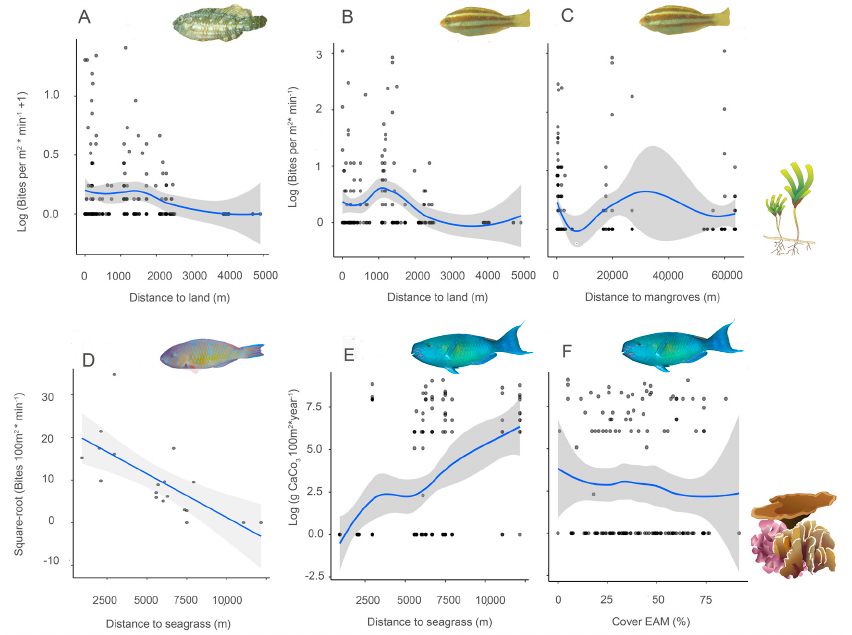
Figure 5. Relationships between significant variables and the number of bites of ( A ) L. vaigiensis and ( B – D ) S. ghobban . ( E , F ) shows bioeroded mass CaCo 3 of S. rubroviolaceus in relation to distance to seagrass ( p = 0.06) and cover epilithic algal matrix (EAM) ( p < 0.05). ( A , B , E , F ) are modelled with Generalized Additive Models (GAMs) and ( D ) with linear regression. Upper panels show seagrass habitats and lower panels